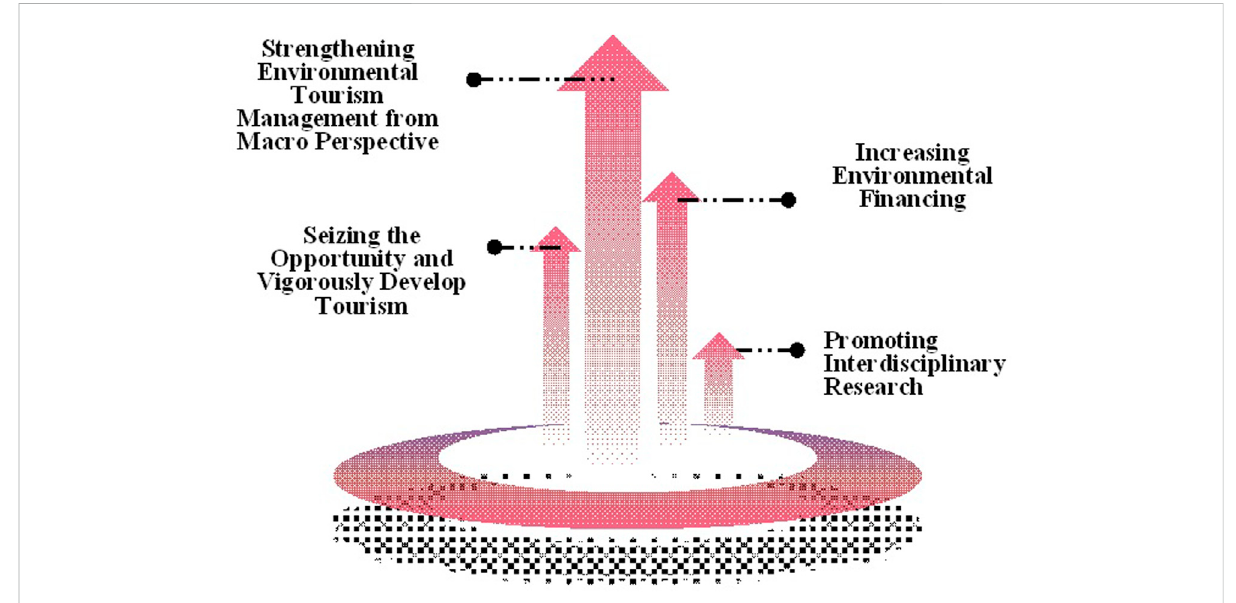
Treatment of the con fl ict between the sustainable development of ecotourism and environmental